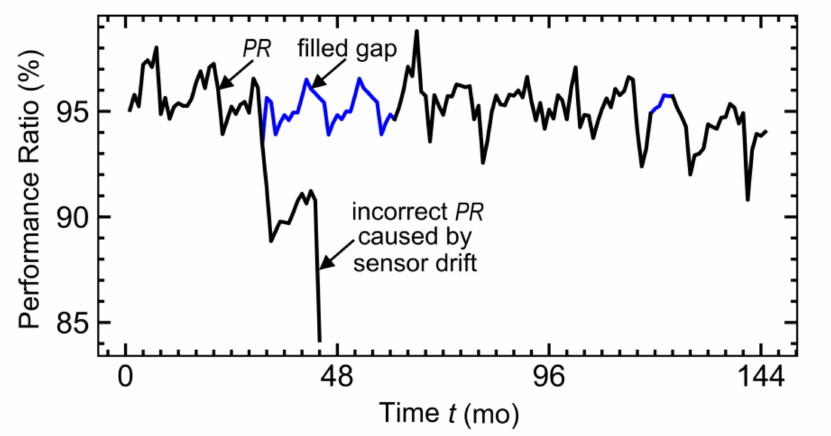
Figure 6. Monthly PR time series of the ase170St multi-c-SI PV system in Stuttgart, Germany calculated with the measured data in black and imputed using the time series reconstruction algorithm in